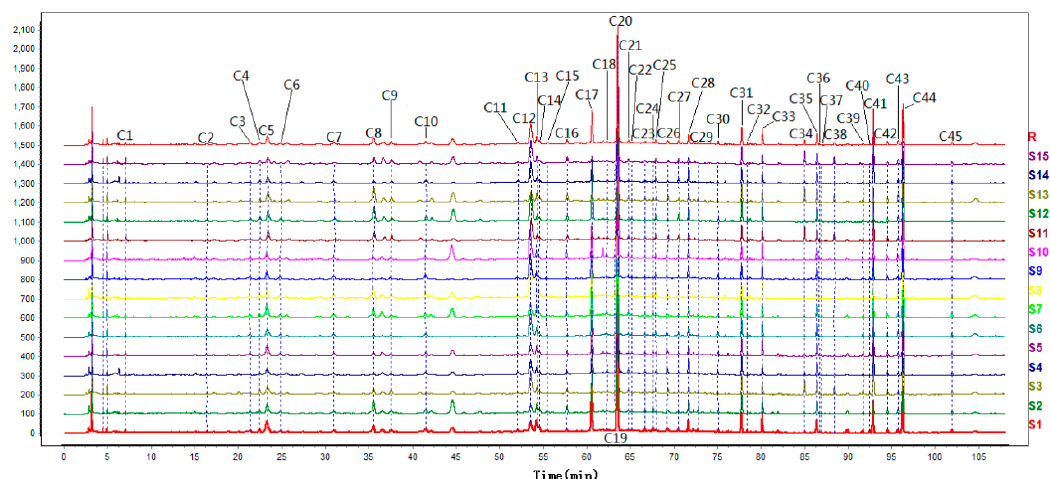
Figure 1. UHPLC chromatograms of 15 batches of Houpo Wenzhong Decoction (HWD) samples from S1–S15. The 45 common peaks (C1–C45) are marked.